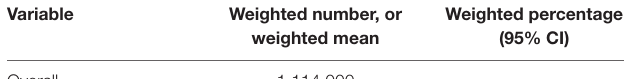
TABLE 1 | Baseline clinical characteristics of emergency department patients with in-hospital cardiac arrest,